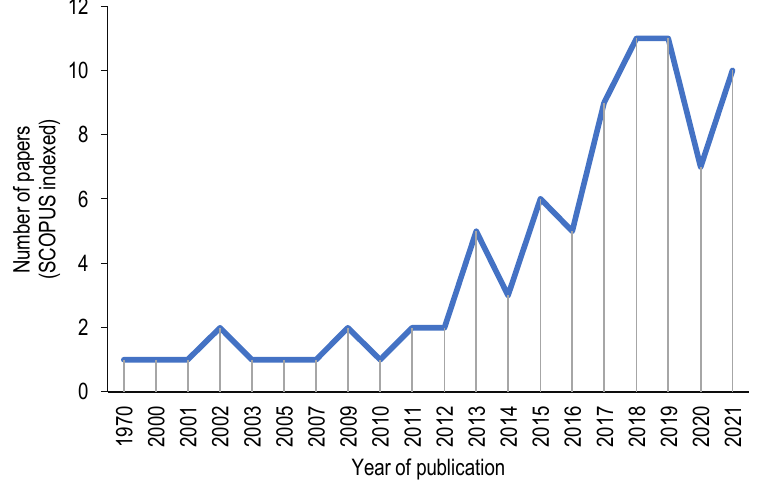
Figure 5. Paper trends for RSM-OD.